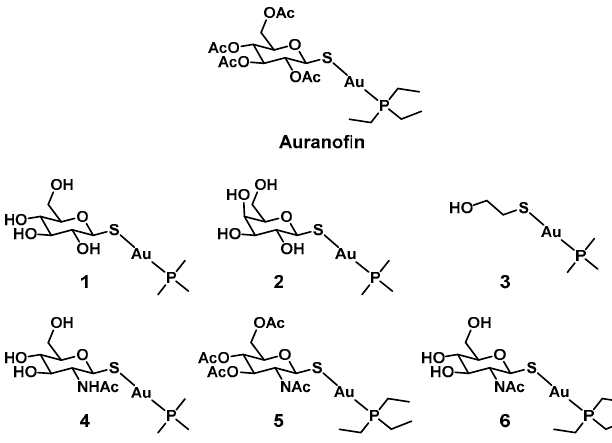
Figure 1. Structures of auranofin and its derivatives.